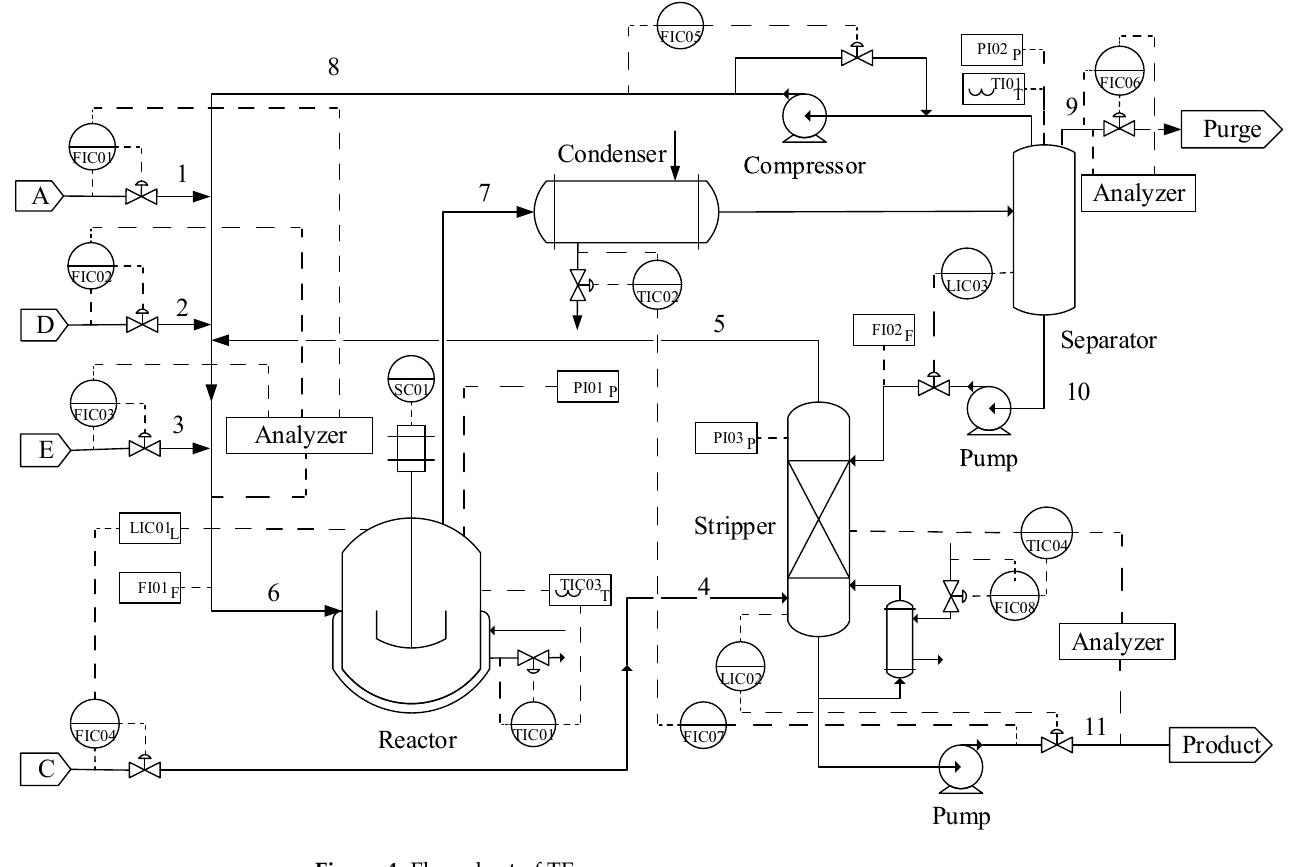
Figure 4. Flow chart of TE process. Table 2. Ten measured variables in TE process.